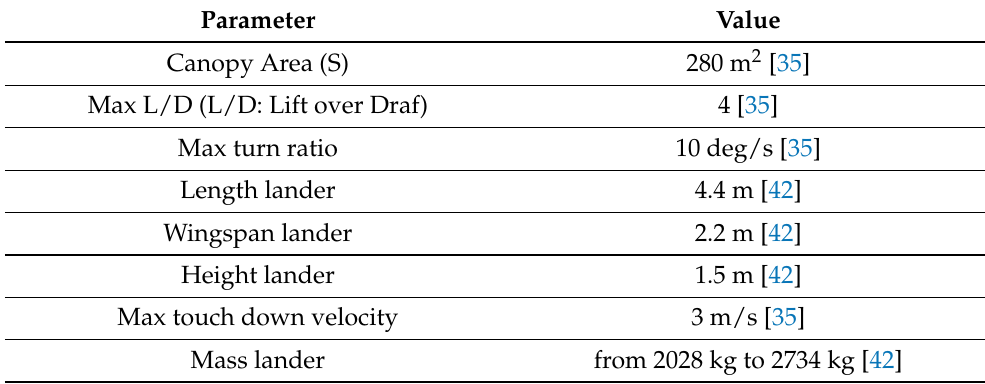
Table 2. Main system parameters used for the PIMENTO simulations in this paper.